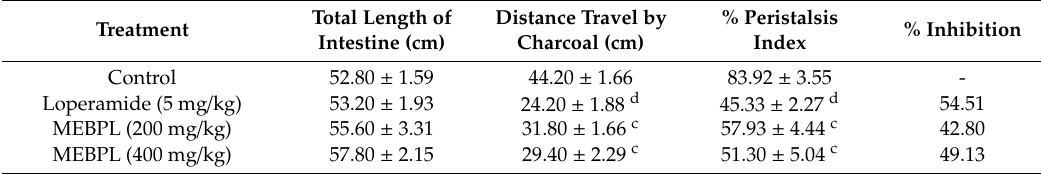
Table 6. Intestinal motility e ff ect of methanol extract of B. pilosa leaves by using charcoal as a marker.